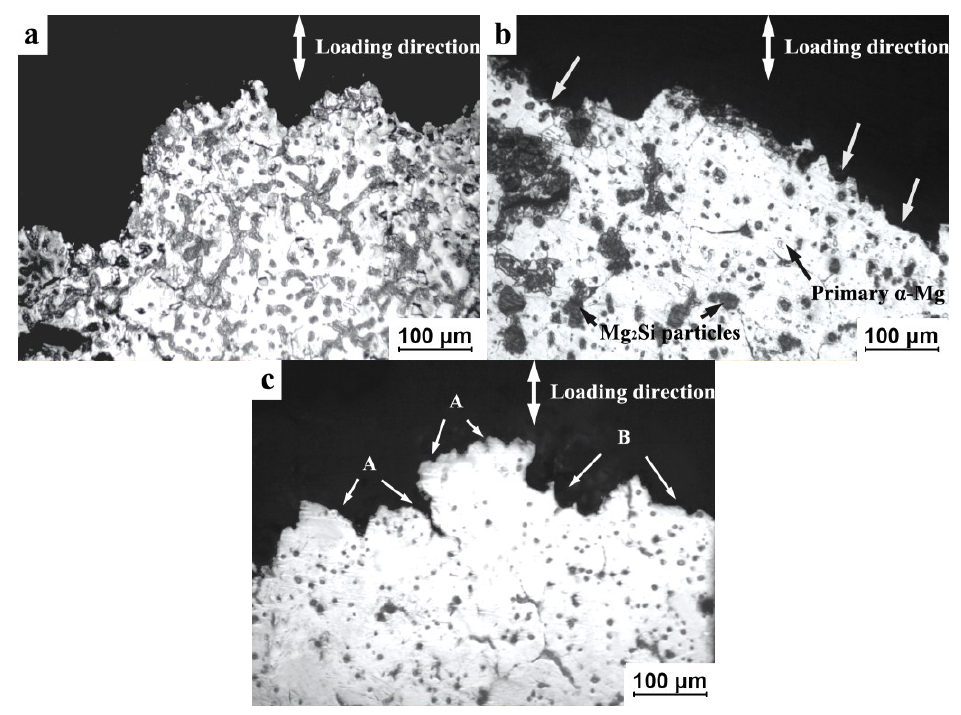
Figure 5. OM images reveal the side-view of the fracture surface: ( a ) as-cast composite; ( b ) thixoforged composite; and ( c ) thixoforged